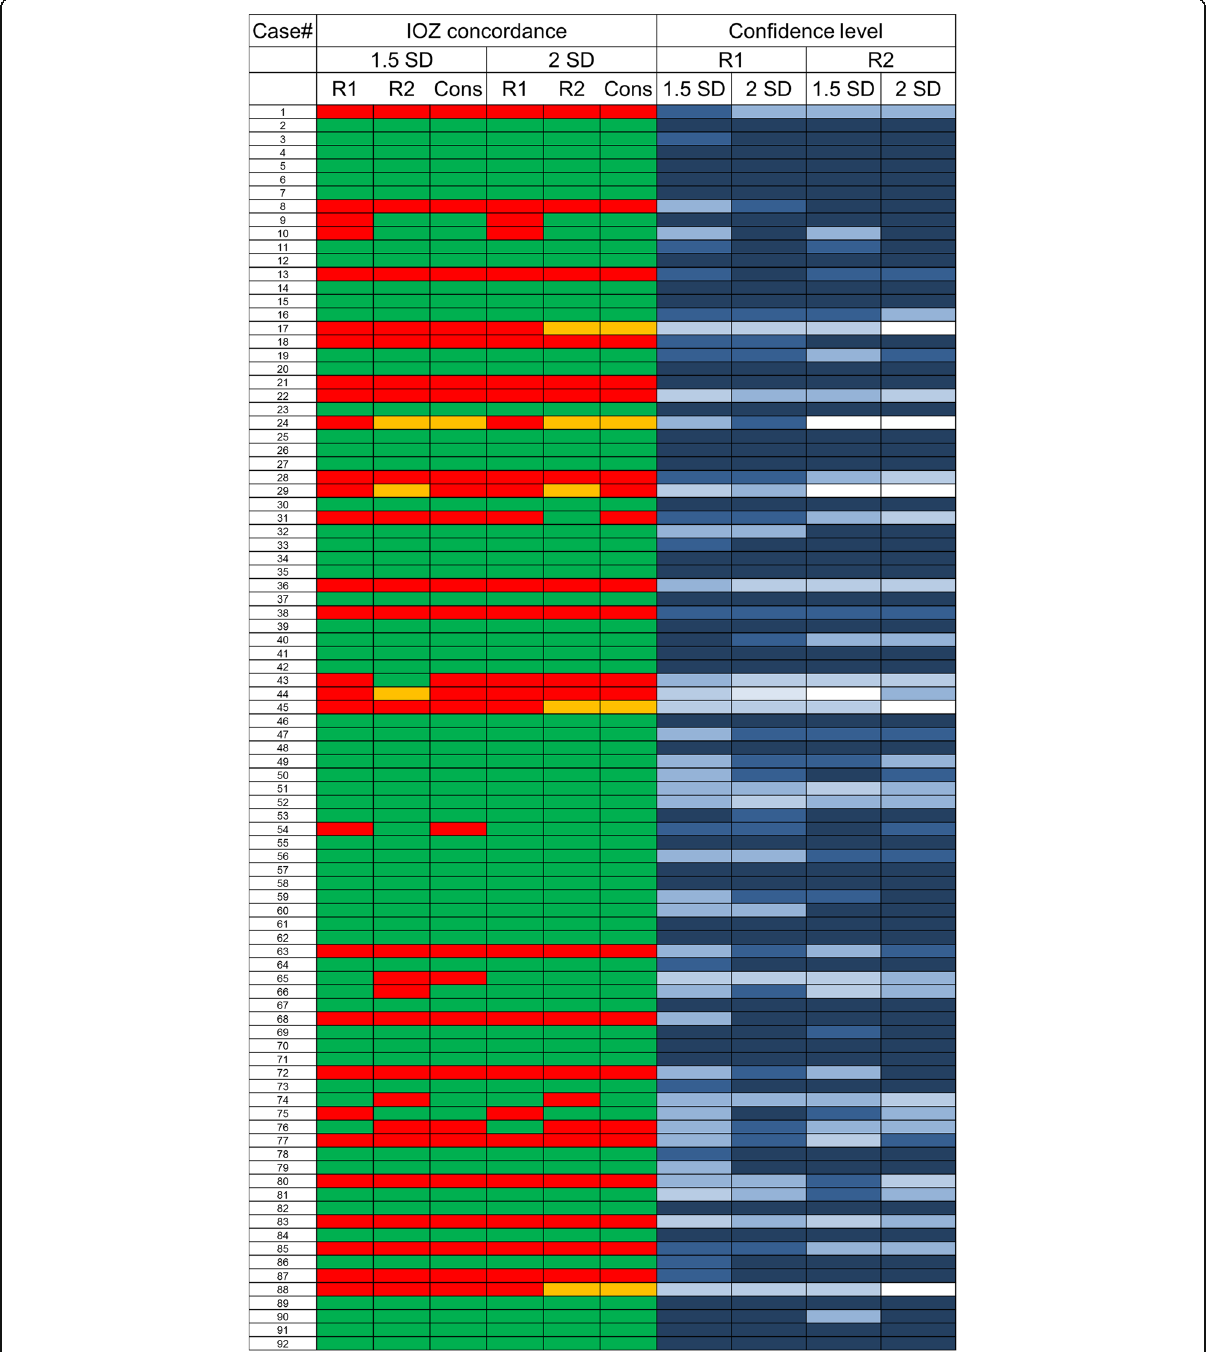
Fig. 2 Reader consensus table for the 92 analyzed SISCOM images. Green = concordance with surgery localization, red = different region, and orange = non-localizing at threshold of z = 1.5 SD and z = 2 SD. Reader confidence level (light blue = 1 to darkest blue = 5). Reader one (R1) = 20 years of experience, reader two (R2) = 10 years of experience, Cons: consensus